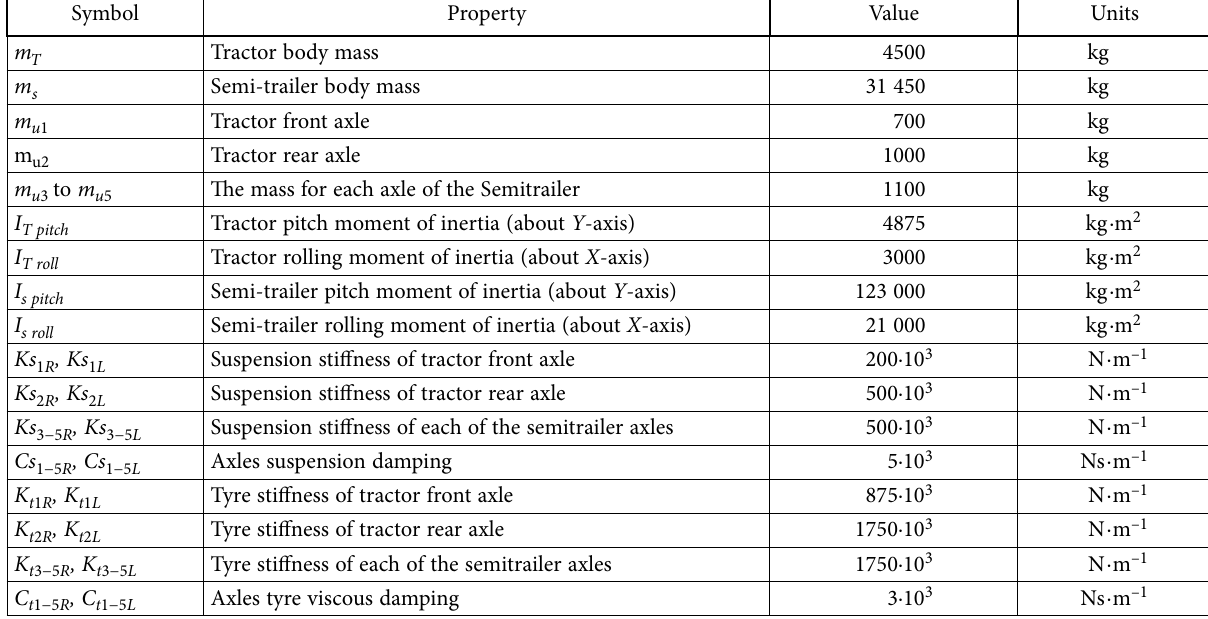
Table 2. Properties of the 5-axle truck model ( R and L refer to right and left wheel respectively) Symbol Property Value Tractor body mass Semi-trailer body mass